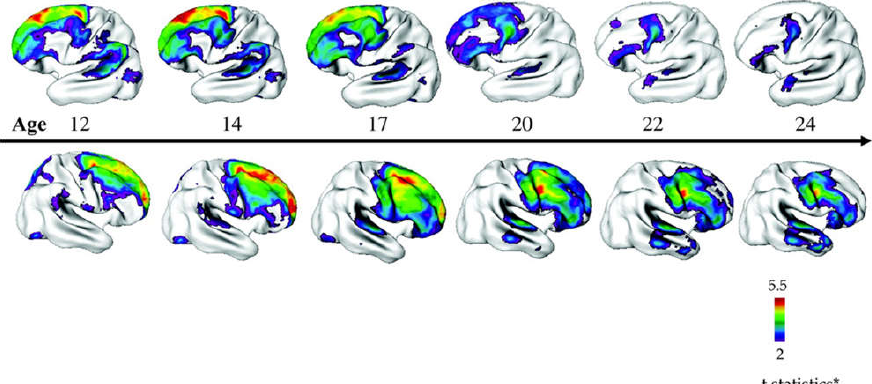
Figure 1. Progression of cortical gray matter loss in patients with childhood-onset schizophrenia (COS) ( n = 70) relative to age-, sex-, and scan interval-matched healthy individuals ( n = 72). Brain templates illustrate areas of significant thinning in patients with COS in a ‘front-to-back’ pattern from adolescence to young adulthood (age 12–24 years). Side bar shows t statistic with threshold to control for multiple comparisons. Figure 1 is reproduced from Gogtay [26] by permission of Oxford University Press, adapted by Greenstein et al. [27] by permission of John Wiley and Sons.